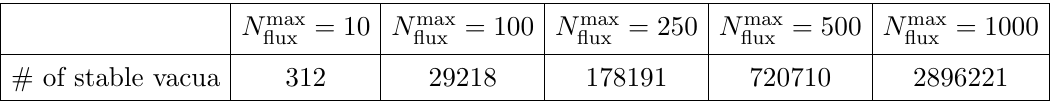
determining the range of (cid:13)ux quanta through the (cid:13)ux